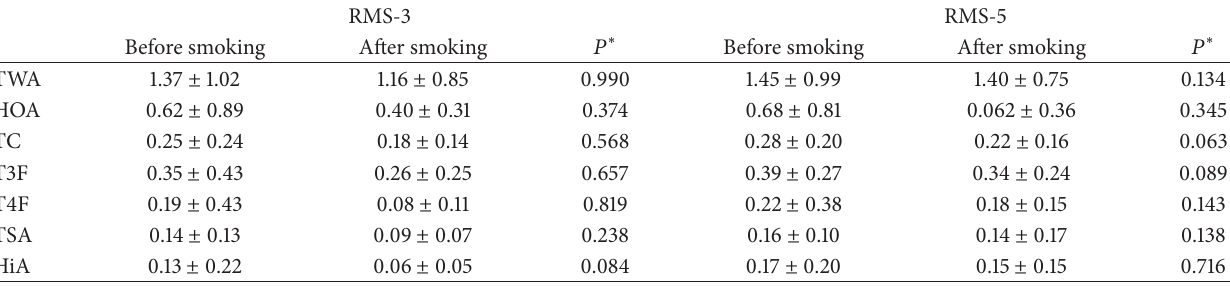
Table 1: Pre- and postsmoking higher order aberrations detected by OPD-Scan II. RMS-3 RMS-5 𝑃